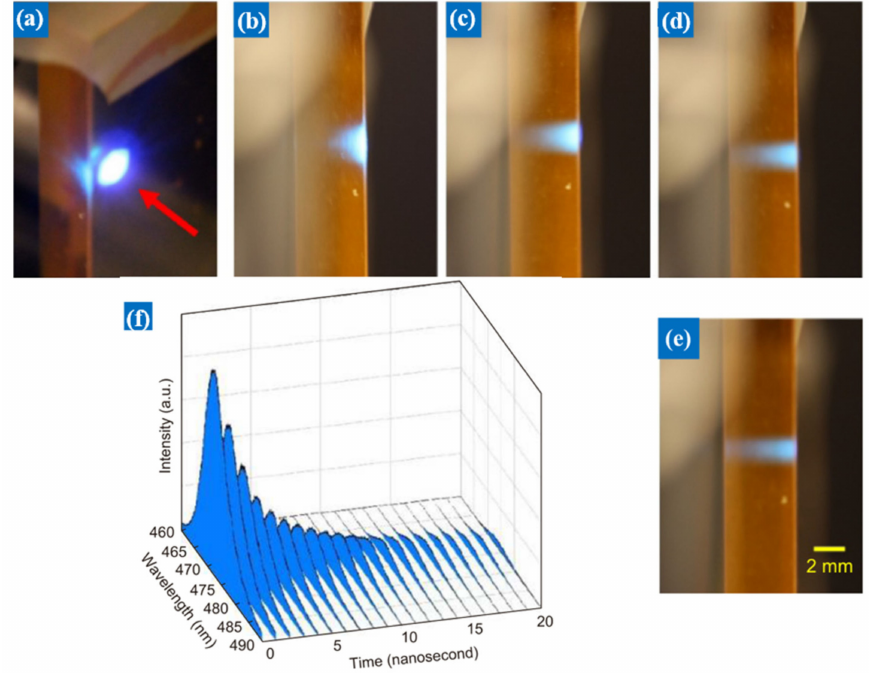
Figure 14. The two-photon-induced fluorescence of polycrystalline ZnSe at 775 nm is dependent on the incident laser intensity. ( a ) Blue fluorescence front view of polycrystalline ZnSe. ( b – e ) are the side views of the fluorescence radiation at incident light intensities of 25GW cm − 2 , 4GW cm − 2 , 1.5GW cm − 2, and 1GW cm − 2 , respectively. As the incident intensity decreases, the depth of fluores- cence radiation in the sample becomes larger. ( f ) is the time-dependent decay curve of polycrystalline ZnSe with fluorescence intensity and wavelength [59]. Republished with permission from Ref. [59]. Copyright 2022Chinese Academy of